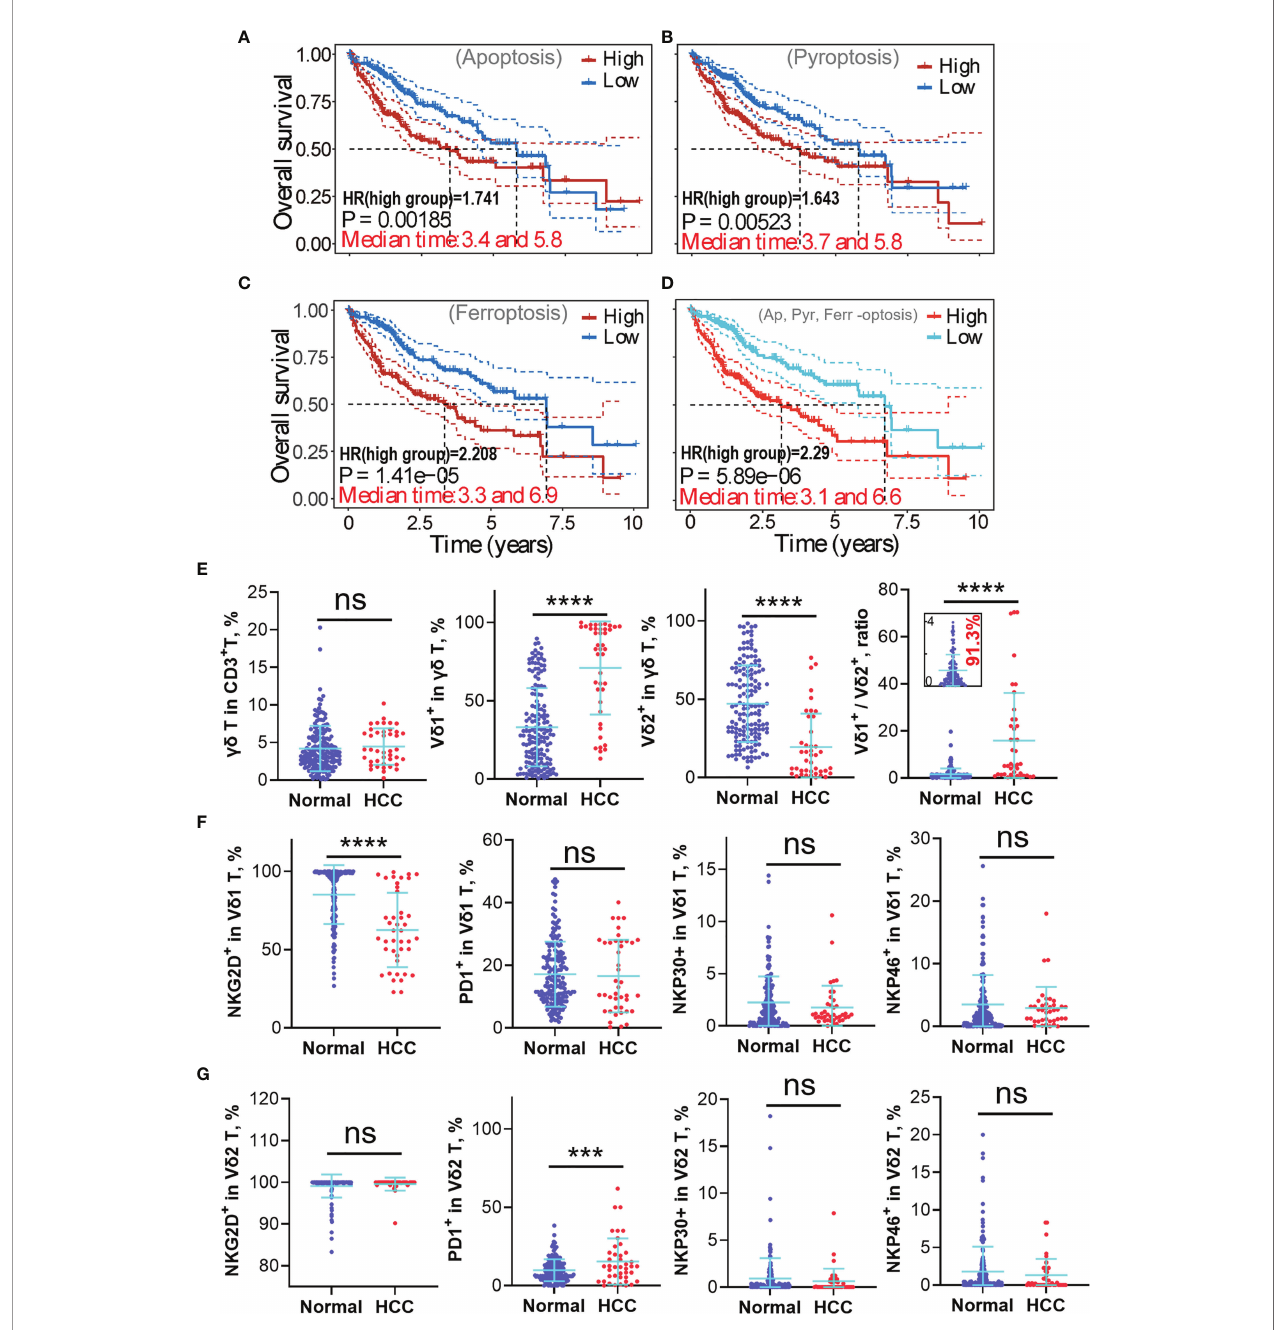
FIGURE 6 | High expressions of apoptosis, ferroptosis, and pyroptosis-related marker genes in hepatocellular carcinoma (HCC) lead to poorer prognosis and implicate gd T-cell depletion, particularly V d 2 + gd T-cell depletion. (A – C) The “ -optosis ” marker genes were used to create the prognostic signature model using the least absolute shrinkage and selection operator (LASSO) Cox regression model (cited from Supplementary Figures 2D, 3D, 4E ), the correlations between the Riskscore and overall survival (OS) are graphically shown here. It shows higher expression of marker genes positively correlates with higher risk coef fi cient (HR > 1), leading to poorer clinical outcome. (D) Correlation between the Riskscore (generated using 15 “ -optosis ” marker genes) and the OS (cited from Supplementary Figure 5E ). Higher Riskscore leads to a poorer prognosis. (E) Circulating gd T-cell phenotypes from the healthy population and HCC patients were analyzed using fl ow cytometry, including the proportion of gd T cell in CD3 + T cells, V d 1 + subset in gd T cell, V d 2 + subset in gd T cell, and the V d 1 + /V d 2 + ratio. (F) Functional phenotypes of circulating V d 1 + gd T cell, including expressions of NKG2D, PD1, NKP30, and NKP46. (G) Functional phenotypes of circulating V d 2 + gd T cell, including expressions of NKG2D, PD1, NKP30, and NKP46. ns, no statistical signi fi cance; ***p < 0.001; ****p <